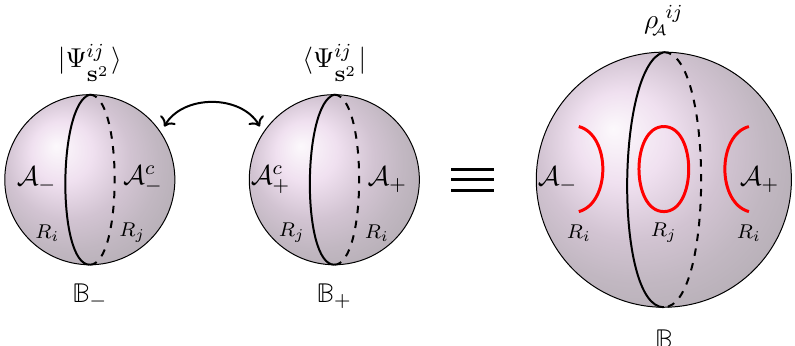
Figure 18 . The state j (cid:9) ij i is obtained by slicing open Z ( S 3 ; R i ; R j ) to expose a three-ball B (cid:0) CS S 2 with the two Wilson lines piercing through the S 2 . The conjugate state is prepared on the other ball B 2 so that the Wilson line R + . Bipartitioning the S i pierces through A while R j pierces through ij which can be seen to be representable via a functional integral A c results in a density matrix (cid:26) A on a single three-ball B whose boundary is A (cid:0) [ A + each of which has the two marked points with representation label R i . The interior of the ball contains a Wilson line on an unknot with the other representation R j .